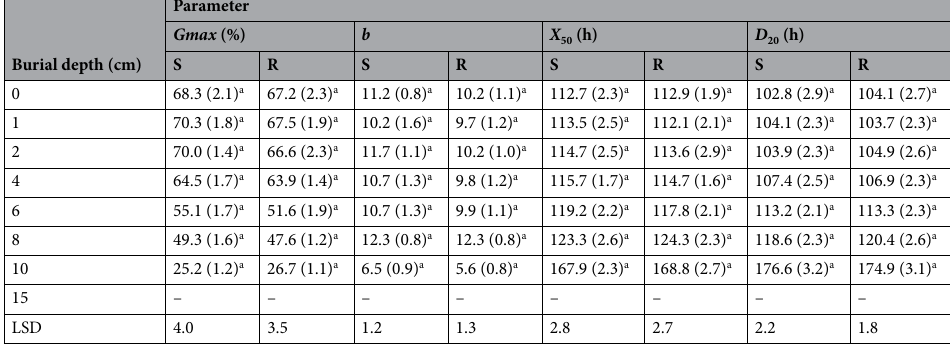
Table 7. Parameter estimates resulted from the fitting of three-parameter sigmoidal function to seed emergence data associated with herbicide-resistant (R) and -susceptible (S) winter wild oat biotypes over time buried under different depths. The values in parentheses denote standard error. Similar letters denote insignificant difference between the R and S biotype in each parameter. Gmax : maximum germination percentage; b : slope at X 50 ; X 50 : time to 50% of maximum germination at each temperature; D 20 : time to 20% germination.